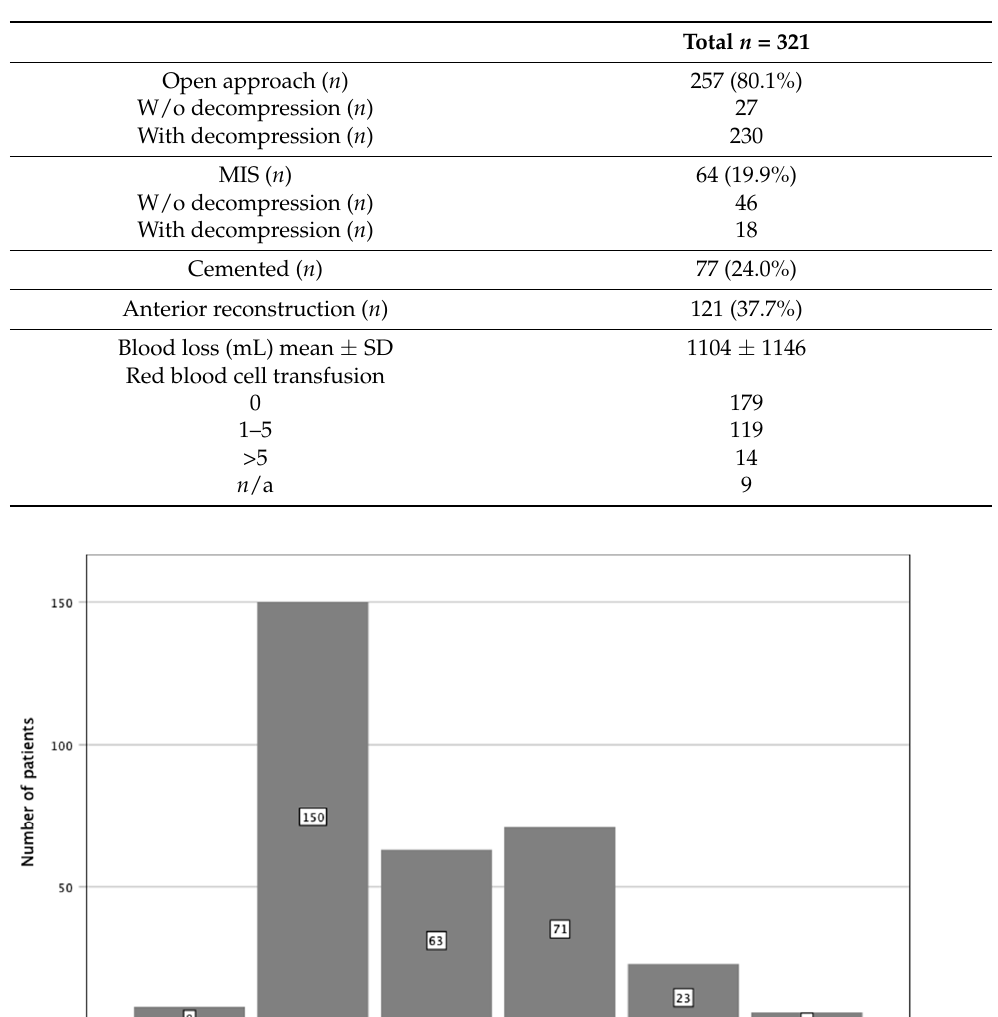
Table 3. Surgical details: MIS = minimally invasive surgery, n = number, n /a = not available, SD = standard deviation, w/o = without.